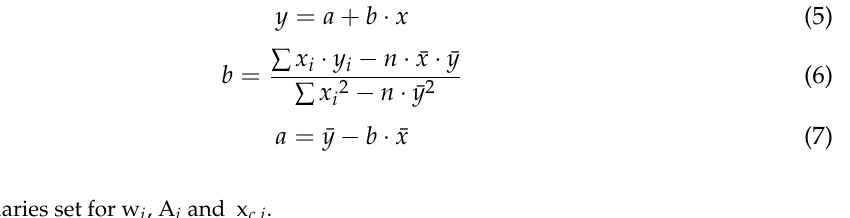
Table 2. Boundaries set for w i , A i and x c , i